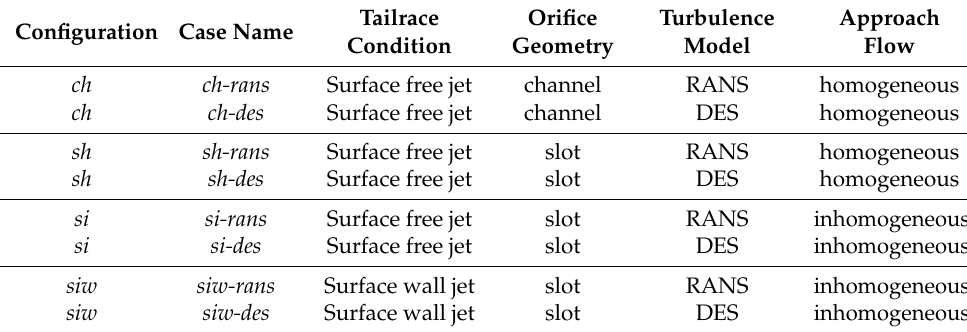
Table 1. Properties of simulated